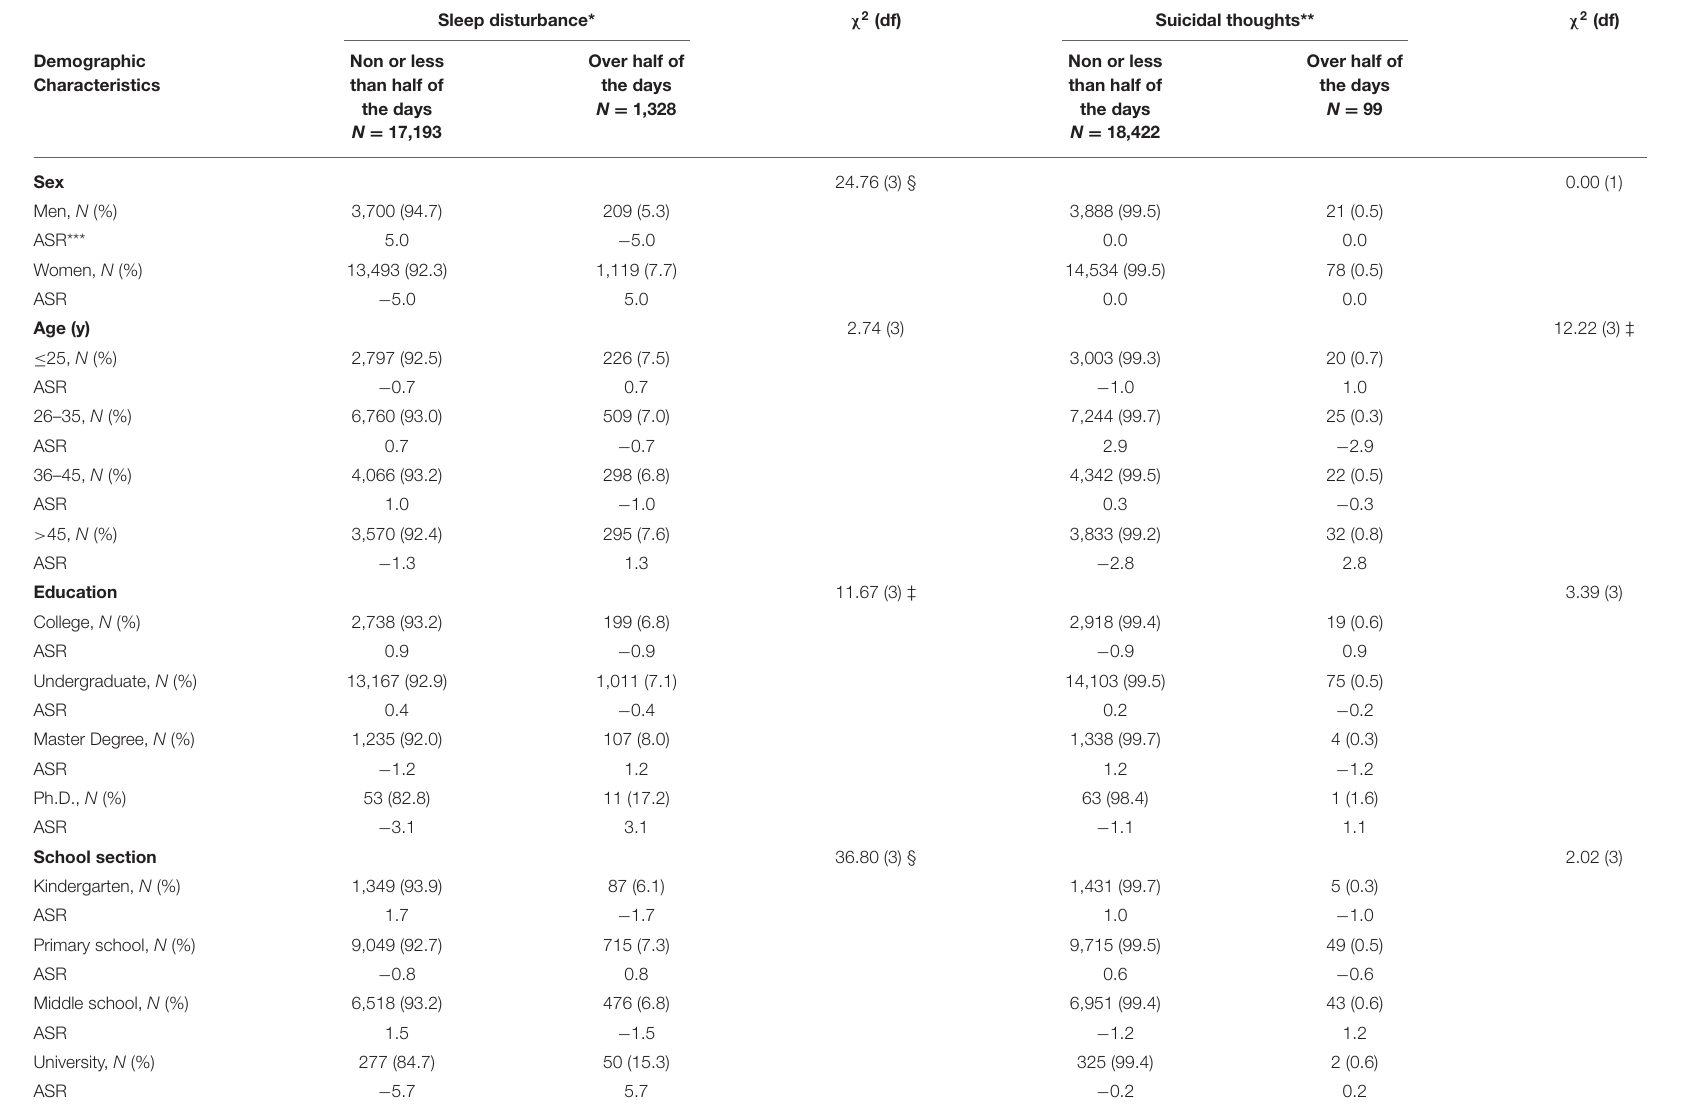
TABLE 3 | Demographic and Sleep disturbance and Suicidal thoughts, Chi-square analysis. Sleep disturbance* χ 2 (df) Suicidal